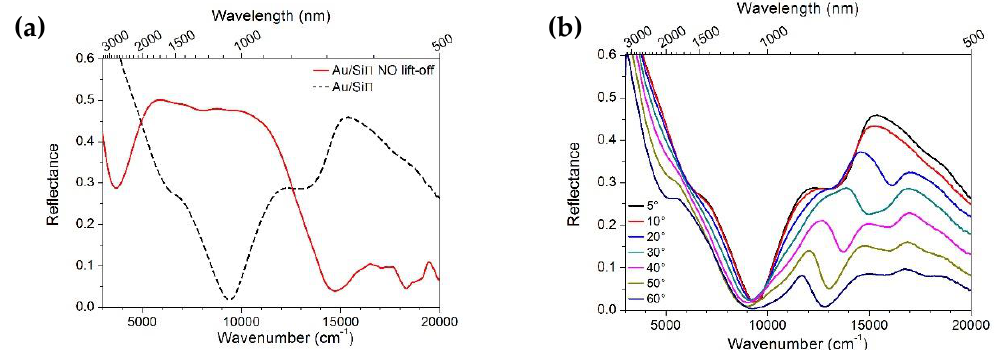
Figure 6. ( a ) Reflectance measurements in the 500–3300 nm range at near-normal incidence of the Au / Si Π structures before (red line) and after (black line) colloidal mask lift-o ff ; ( b ) Angle dependent reflectance for the Au / Si Π structures after lift-o ff of TM light polarization.